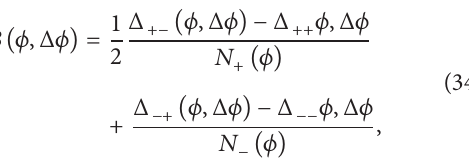
for charged kaon pairs from Au+Au collisions at √𝑠 inv